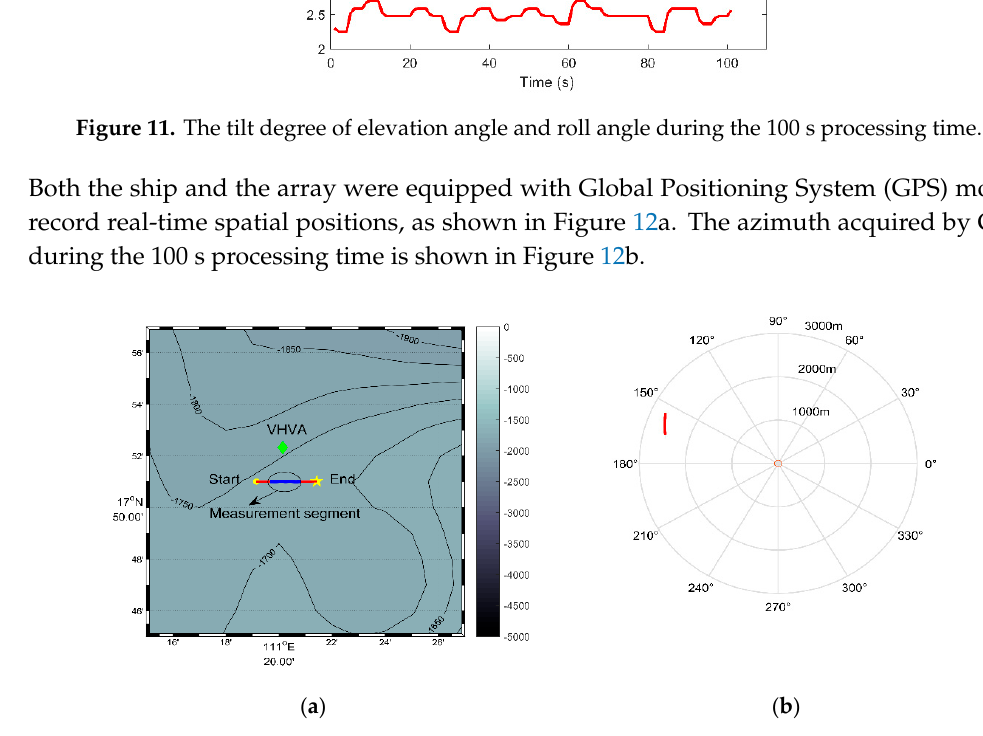
Figure 10. Experiment configuration.